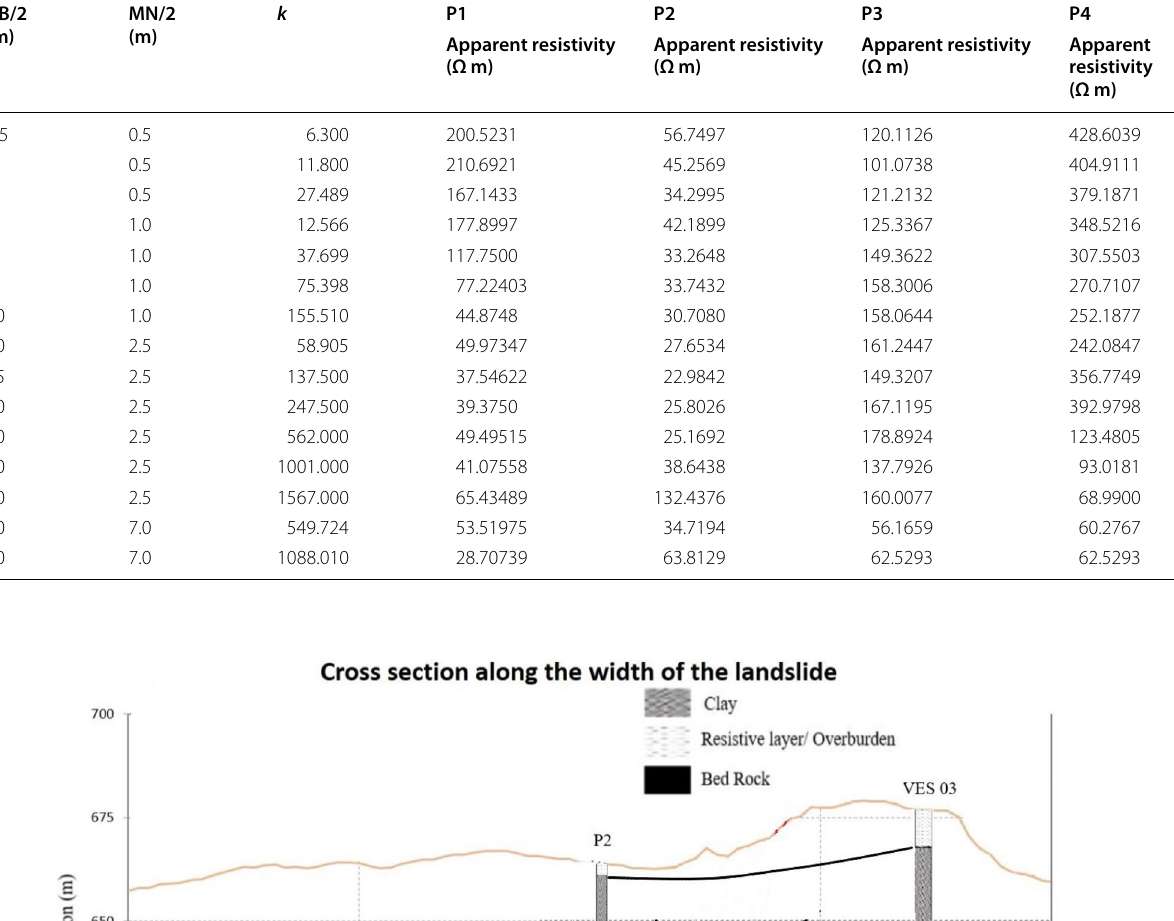
Table 2 Measured resistance values and calculated resistivity values